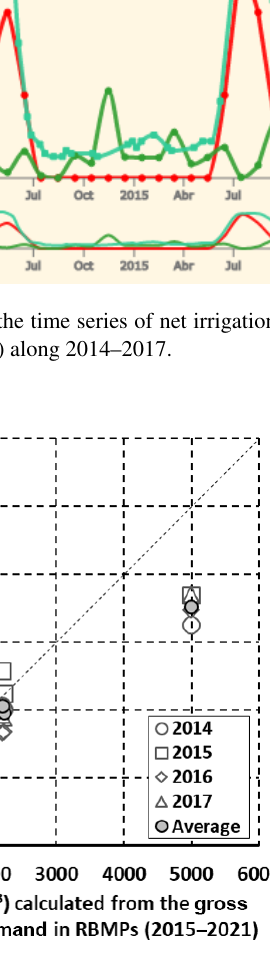
Figure 4. Comparison among the RS-based NIWR and NIWR cal- culated from official RBMPs for the Spanish mainland along 2014–